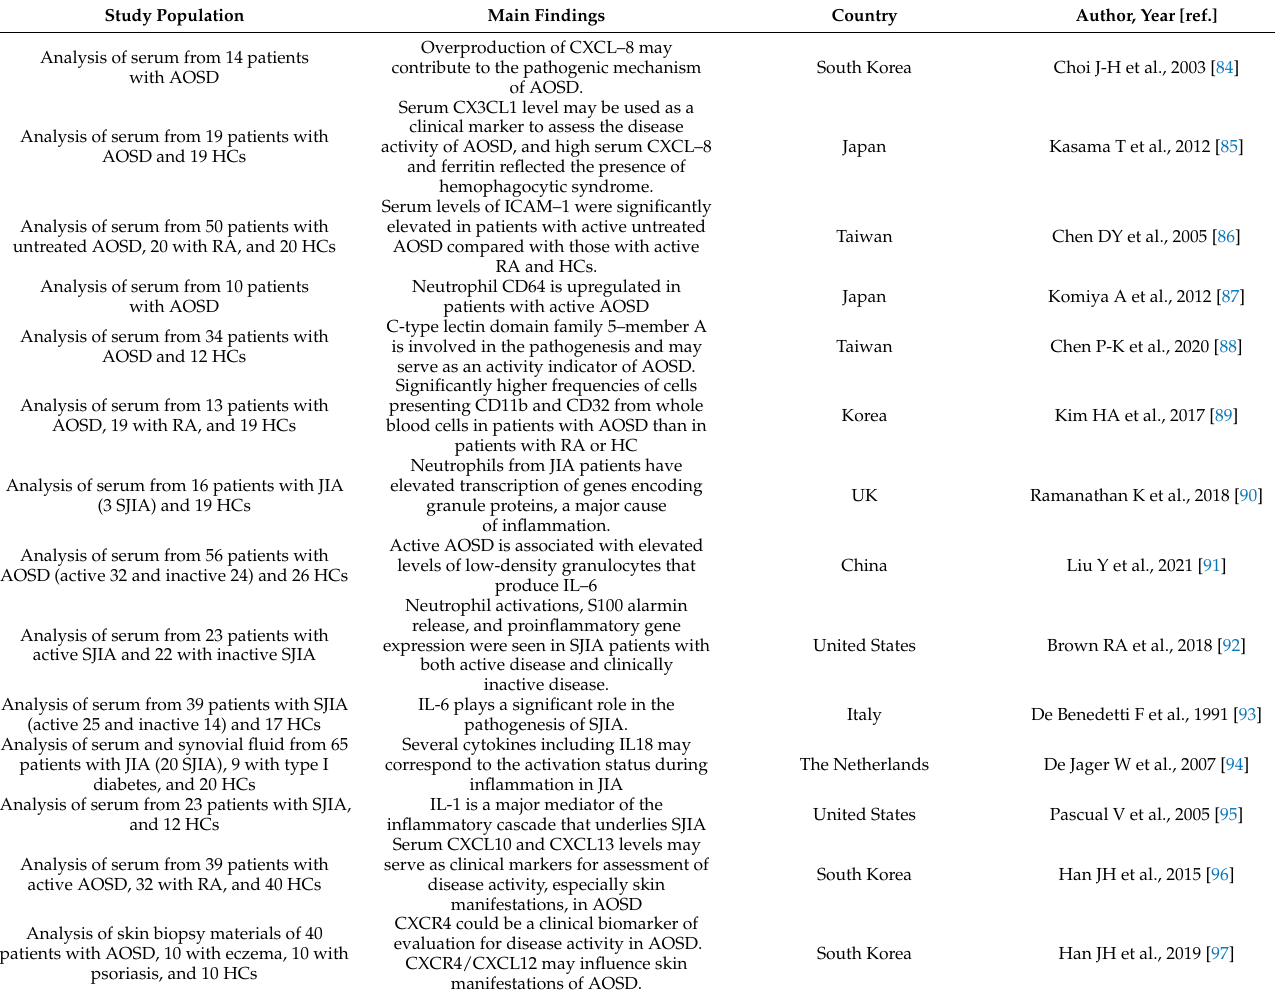
Table 1. List of studies indicating association between neutrophils and